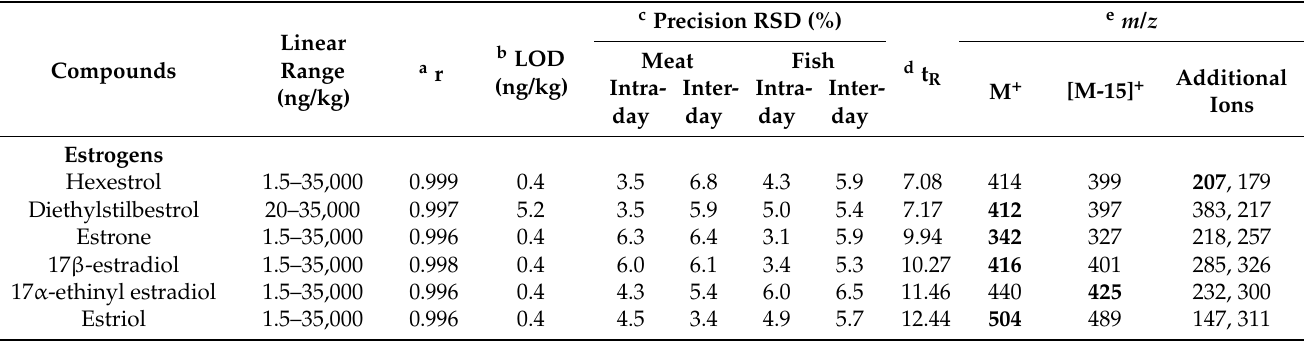
Table 1. Retention time and analytical figures of merit of the proposed method SPE-GC-MS and mass values used for MS